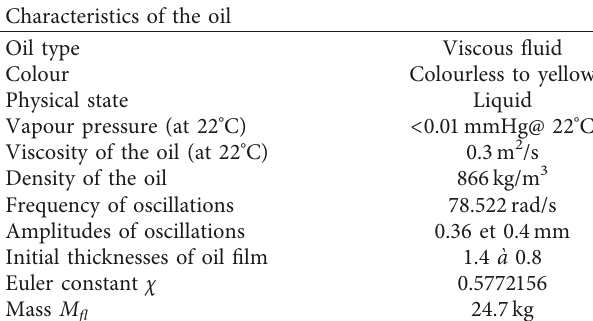
Table 2: Physical properties of the viscous